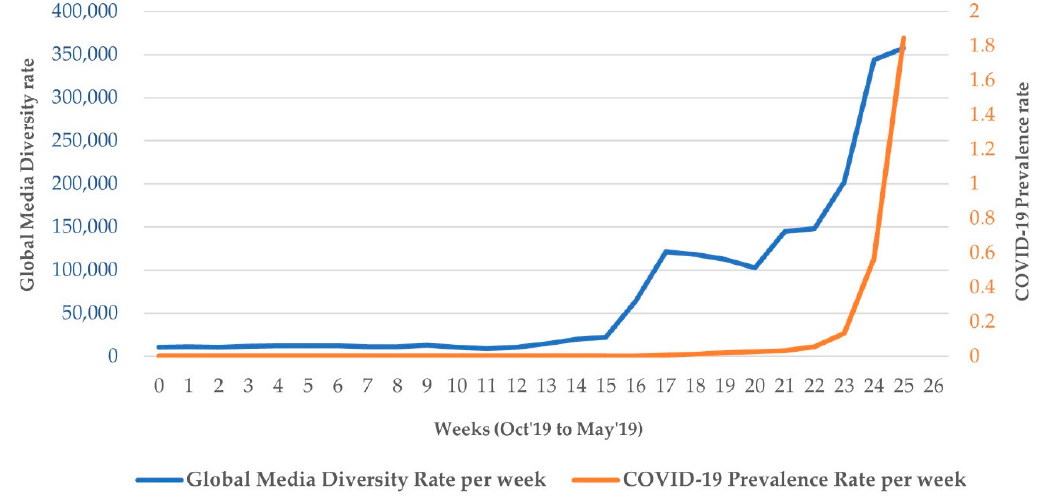
Figure 1. Global media diversity rate and COVID-19 prevalence rate over 25 weeks from a baseline period